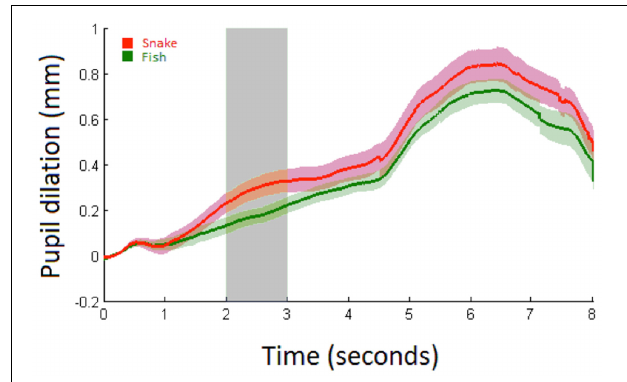
FIGURE 5 | Average pupil dilation (mm) for snakes (red) and fish (green) in Study 2 over 8 s with shaded areas showing the standard errors. Stimulus onset is at 0 s with a duration of 5 s at which a white screen onsets. The analysis time period is marked in light gray.